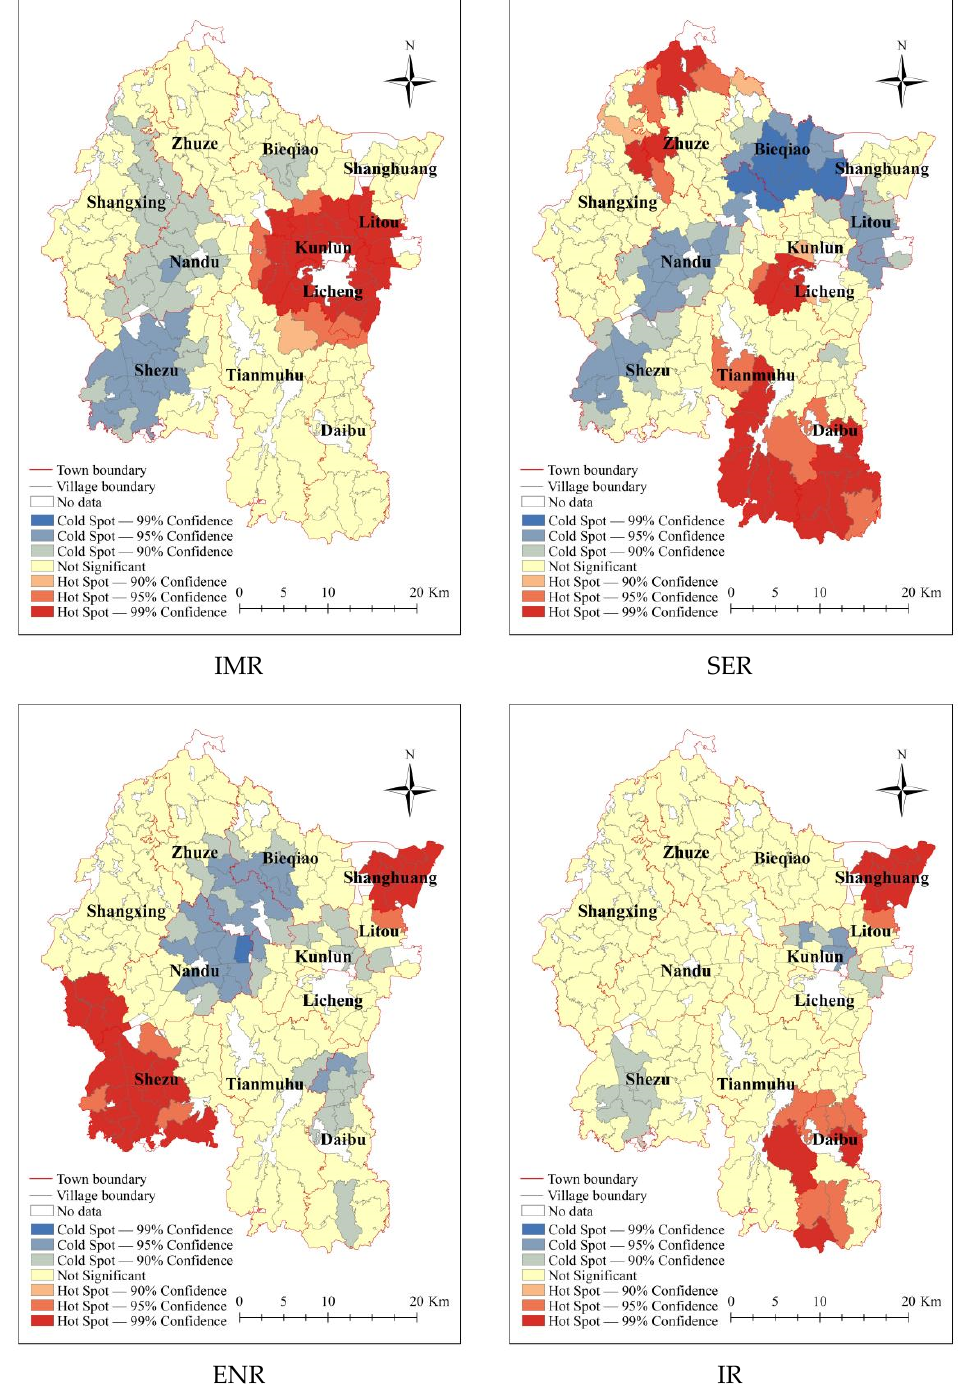
Figure 5. Spatial hot/cold pattern features of non ‐ grain production rates in four categories.